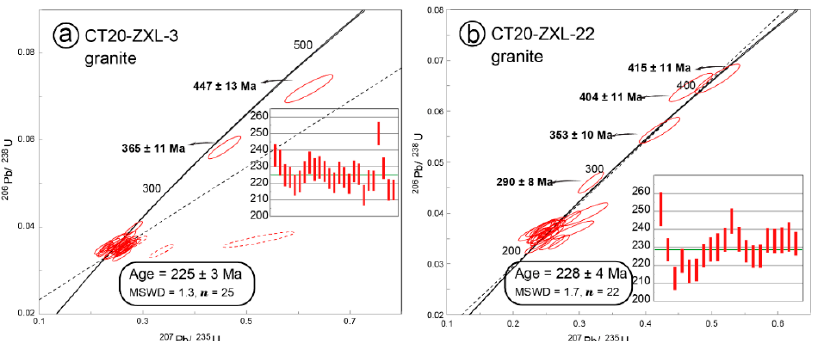
Figure 11. U-Pb Concordia diagrams for samples CT20-ZXL-3 (granite) and CT20-ZXL-22 (granite), which were sampled from the Hercynian intrusions in the Taoxi dome. ( a ) Concordia diagram and weighted average age diagram of sample CT20-ZXL-3. ( b ) Concordia diagram and weighted average age diagram of sample CT20-ZXL-22.